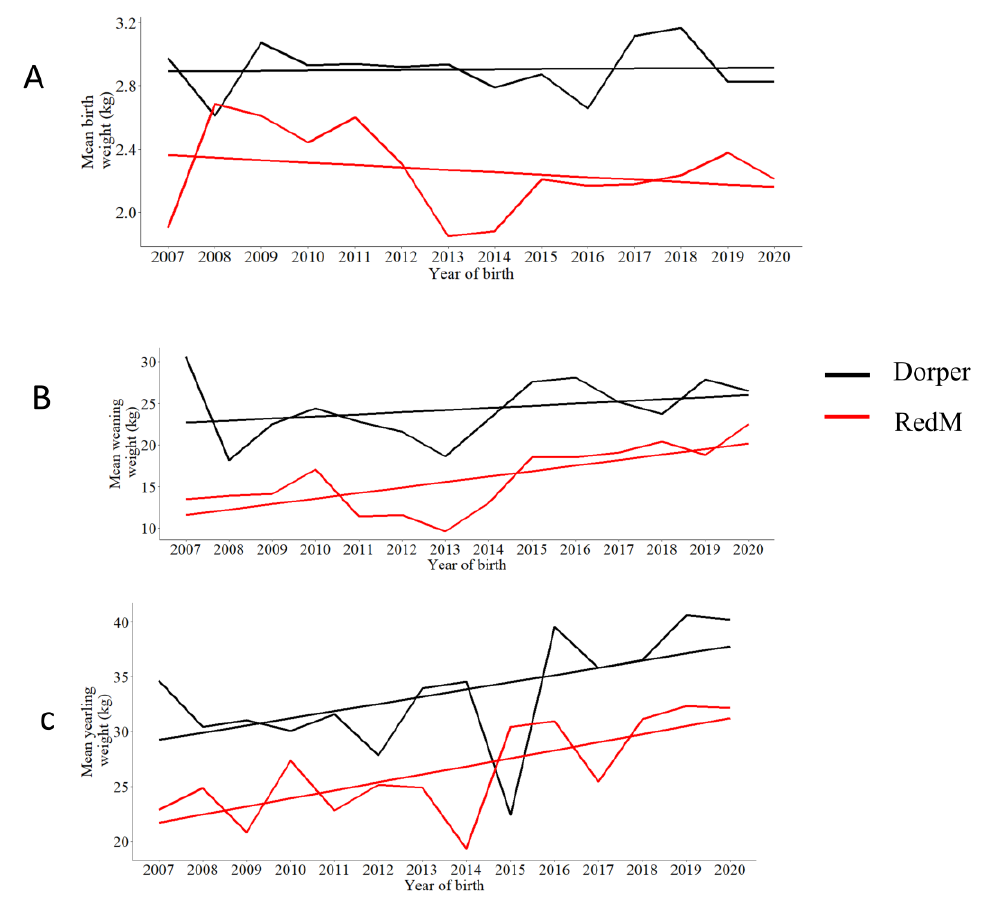
Figure 2. Comparative phenotypic trends for growth weights. ( A ) Phenotypic trend over the years for birth weight; ( B ) phenotypic trend over the years for weaning weight; ( C ) phenotypic trend over the years for yearling weight.